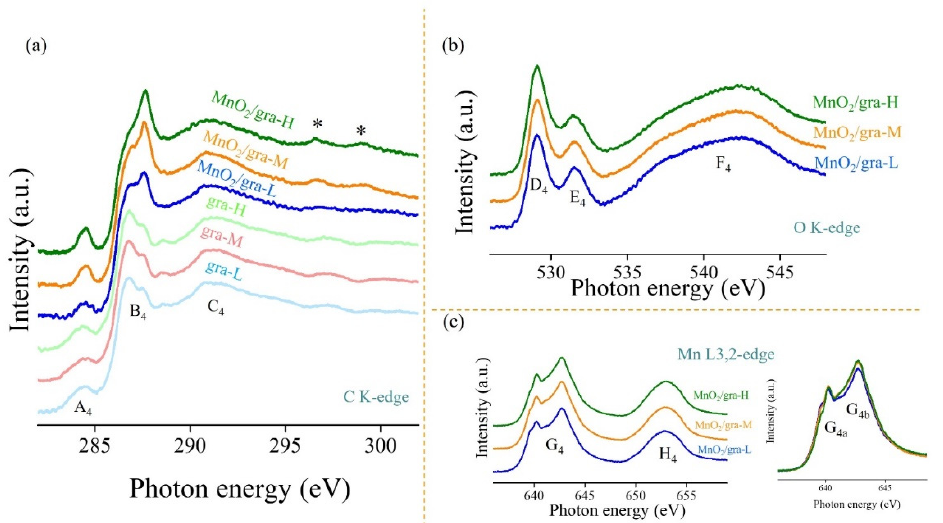
Figure 4. ( a ) C K-edge, ( b ) O K-edge, and ( c ) Mn L3, 2-edge XAS spectra of extended graphite and MnO 2 /extended graphite. Inset in ( c ) is the region of Mn L3-edge XAS spectra. The features (denoted as *) at 298.6 and 301.0 eV are potassium ions and water molecules within the interlayer space of MnO 2 structure via spontaneous redox reaction in the KMnO 4 solution.